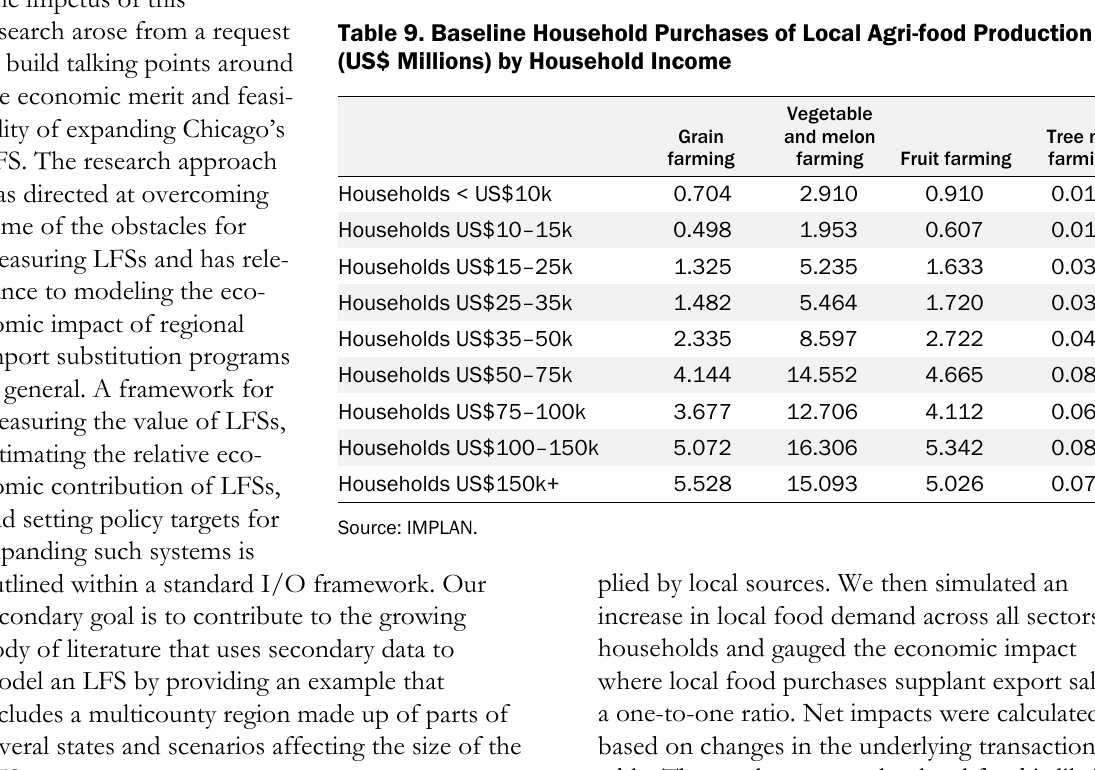
Table 9. Baseline Household Purchases of Local Agri-food Production (US$ Millions) by Household Income